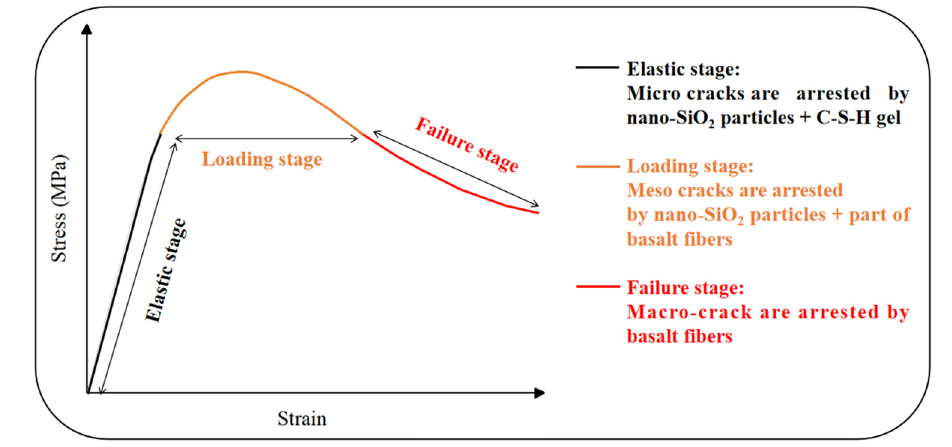
Figure 17: Multi - scale process of the compression failure of RAC.